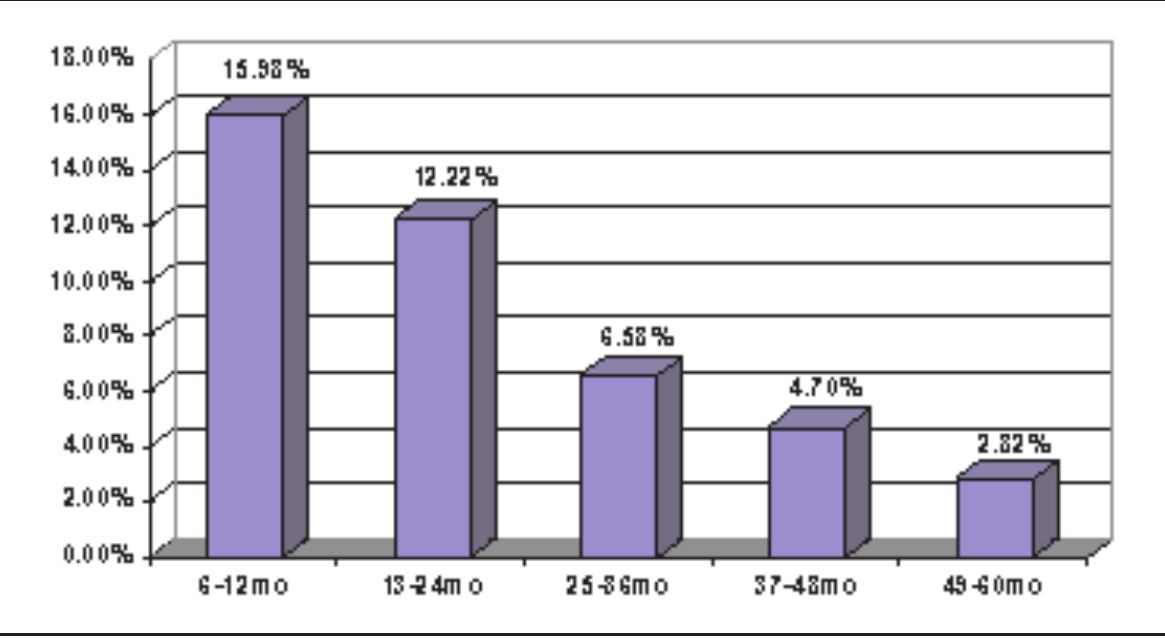
Fig. 2: Percentage of anemia according to age